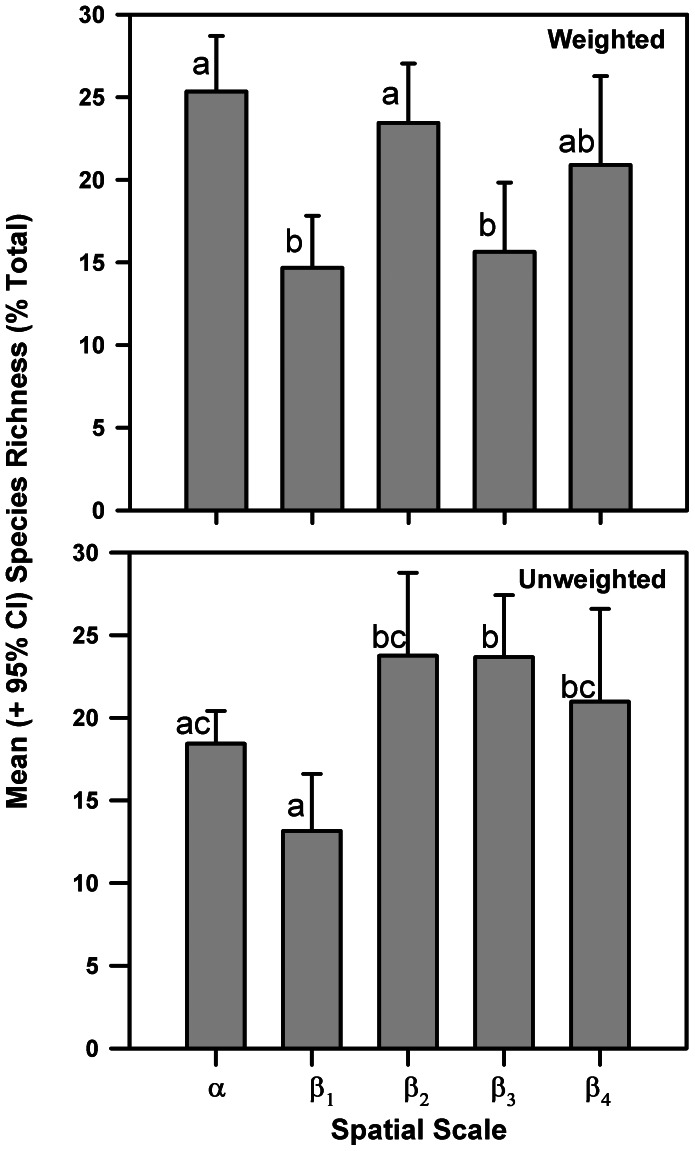
Differences in the mean (+95% confidence interval) temporal contribution of diversity components to species richness in Long Island Sound.Spatial scale associated with each diversity component is given in Fig. 2. Although the mean values are presented for the unweighted partition, a Kruskal-Wallis test was used to test for differences in medians. Lowercase letters show results of post-hoc tests, diversity components sharing the same letters were not significantly different (p<0.05).